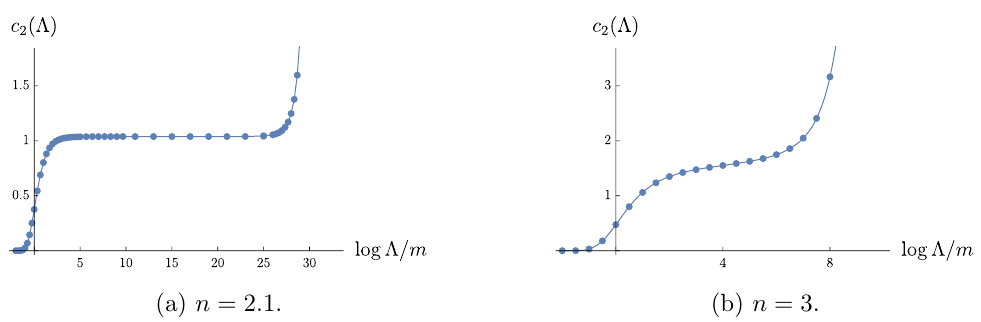
Figure 6. The value of c along the RG (cid:13)ow. The mass m is the mass of the particles in the fundamental of O ( n ).